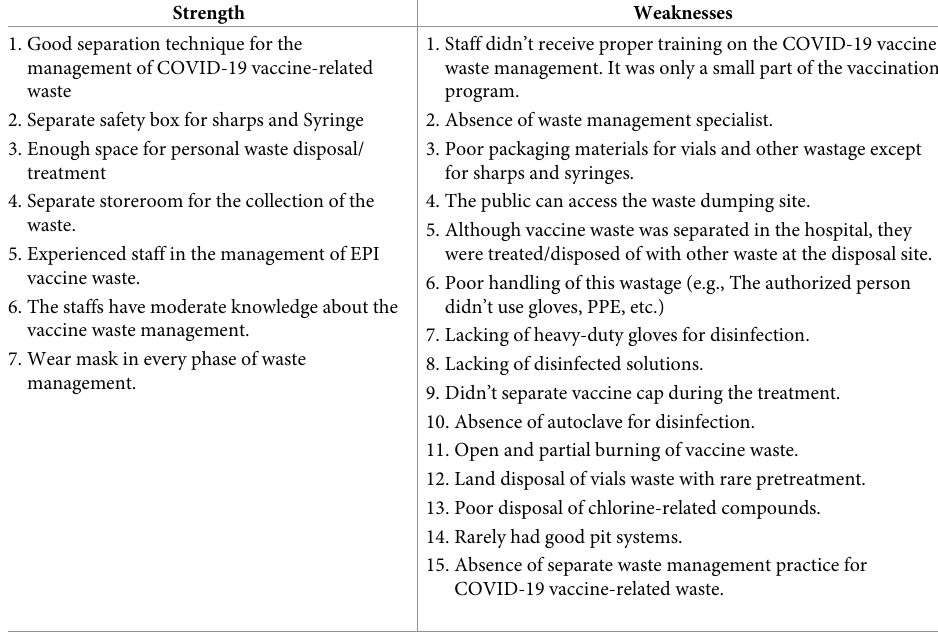
Table 8. SWOT analysis for COVID-19 vaccine waste management (strengths and weaknesses).